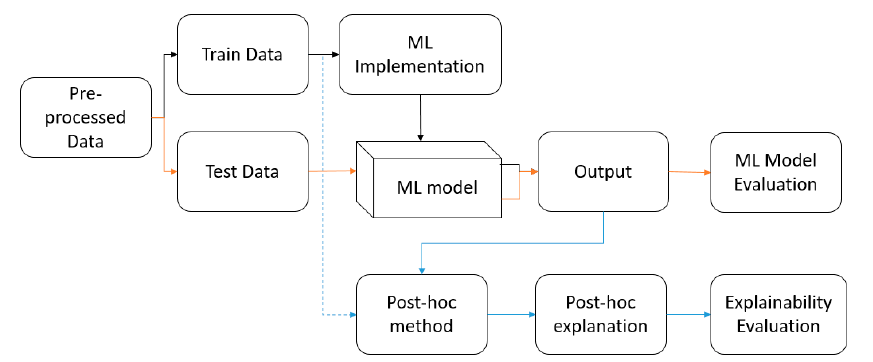
Figure 2. ML process with a training sub-process (black arrows), a testing sub-process (orange arrows), and a post-hoc explanation sub-process (blue arrows).